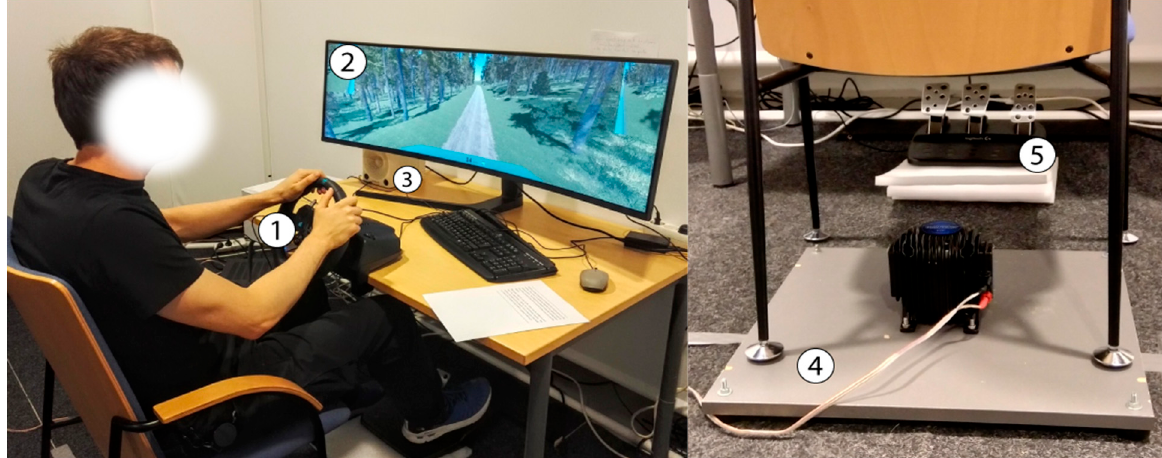
Figure 1. Multimodal driving simulator set-up: 1 and 5—Logitech G29 Driving Force wheel and pedals, 2—49” curved display, 3—speaker, and 4—Buttkicker LFE.